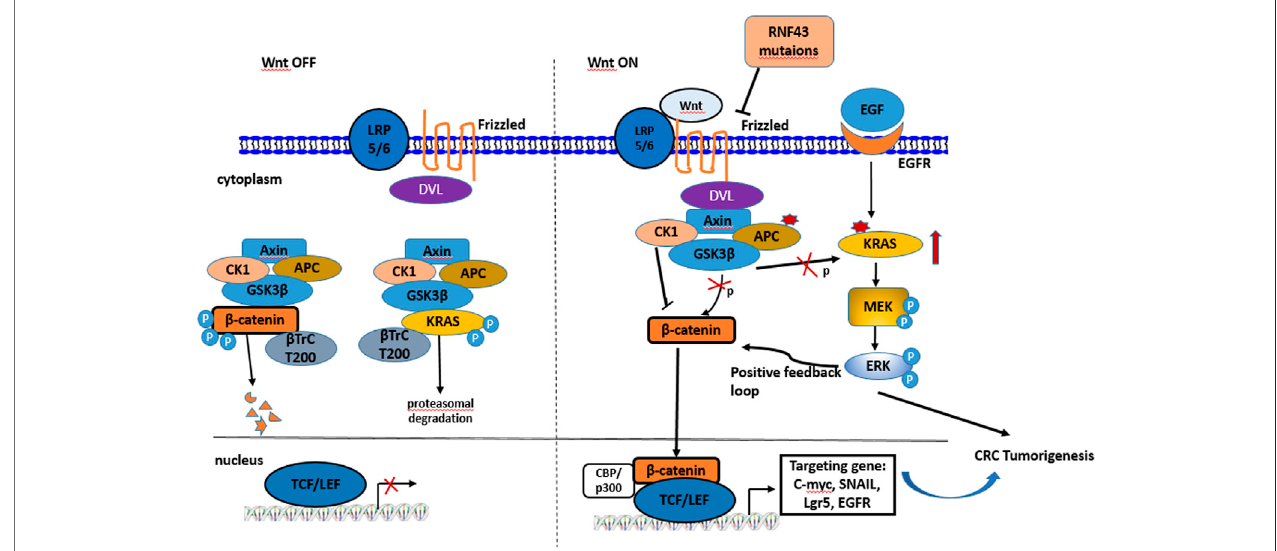
FIGURE 1 | Schematic illustration of the Wnt/ β -catenin signaling pathway in CRC. (A) Inactive Wnt/ β -catenin pathway. In the absence of Wnt ligands, destruction complex phosphylates ß -catenin and KRAS for ubiquitination and proteolytic degradation; (B) Active ß -catenin pathway and crosstalk with KRAS/ERK pathway. In the Wntstimuli orAPCloss,GSK3 β becomesinactivestatus,leadingtothehigh levelsofcytoplasmic ß -cateninand KRAS. WhileKRASmutationshave apositivefeedback loop with the level of cytoplasmic ß -catenin. In addition, RNF43 mutations can relieve the degradation of fi zzled protein and activate Wnt/ β -catenin pathway.